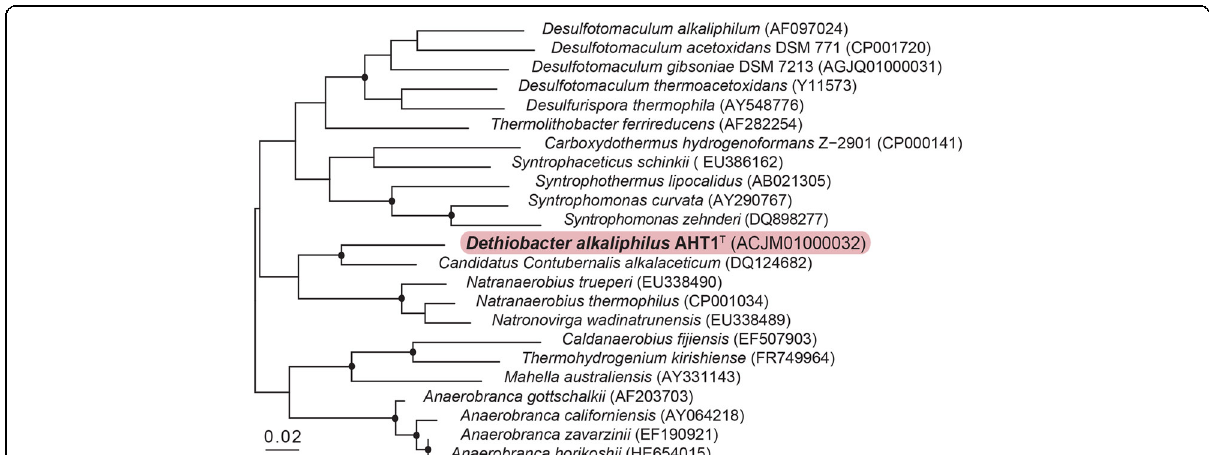
Fig. 2 Neighbour-joining tree based on 16S rRNA gene sequences showing the phylogenetic position of D. alkaliphilus AHT1 T to other species within the phylum Firmicutes . The Deltaproteobacteria were used as an outgroup, but were pruned from the tree. The dots indicate bootstrap values between 80 and 100%. The scale bar indicates a 2% sequence difference. The tree was constructed with the ARB software package [48] and the SILVA database [29]. The bootstrap values were calculated using MEGA-6